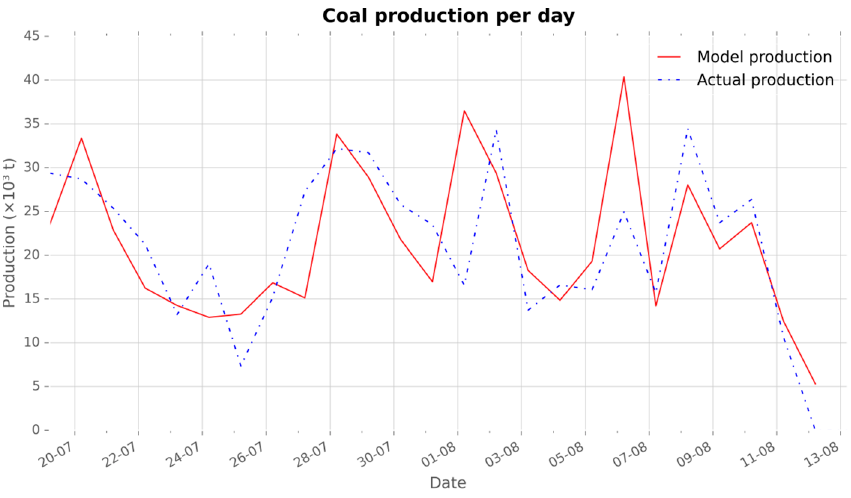
Figure 12. Comparison of daily production of coal, Experiment 1.